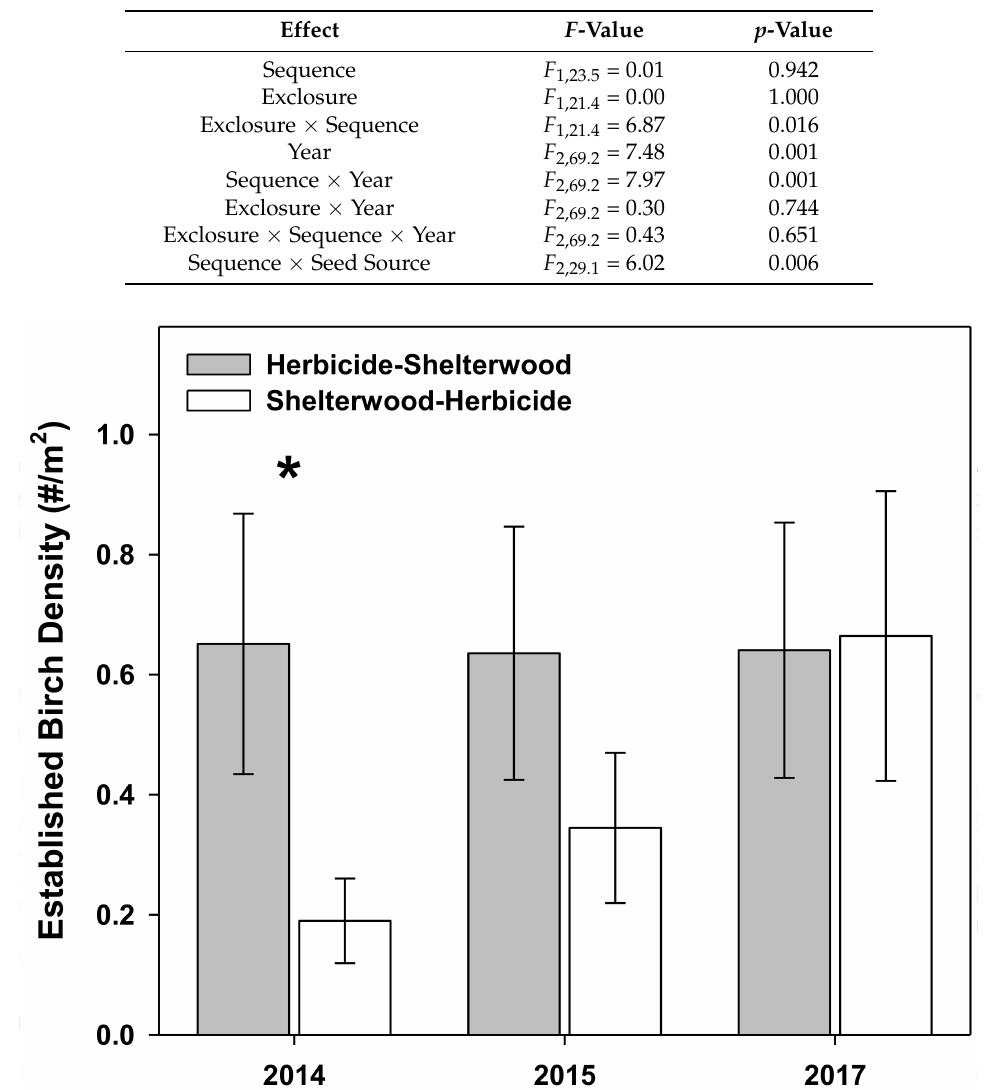
Figure 1. Effect of pre- versus post-shelterwood harvest herbicide application on birch seedling densities (# individuals >5 cm/m 2 ) over time. Asterisks denote significant Bonferroni-corrected difference between treatments within a census